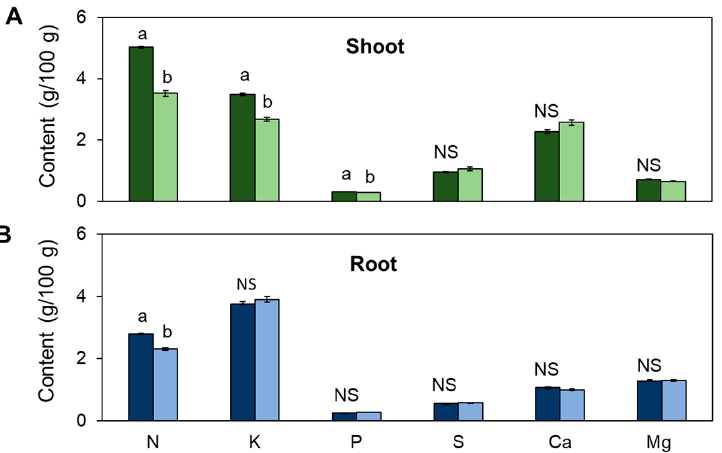
Figure 2. Effect of nitrogen supply levels on the uptake of macronutrients. Concentration (g/100 g) of N, K, P, S, Ca, and Mg in leaves ( A ) and roots ( B ) of plants grown under 8 (dark colored bars) and 4 (light colored bars) mM N for 20 days. Values are means (±SE) of 3 independent determinations in different biological replicates. For each nutrient, different letters indicate significant differences ( p < 0.05).